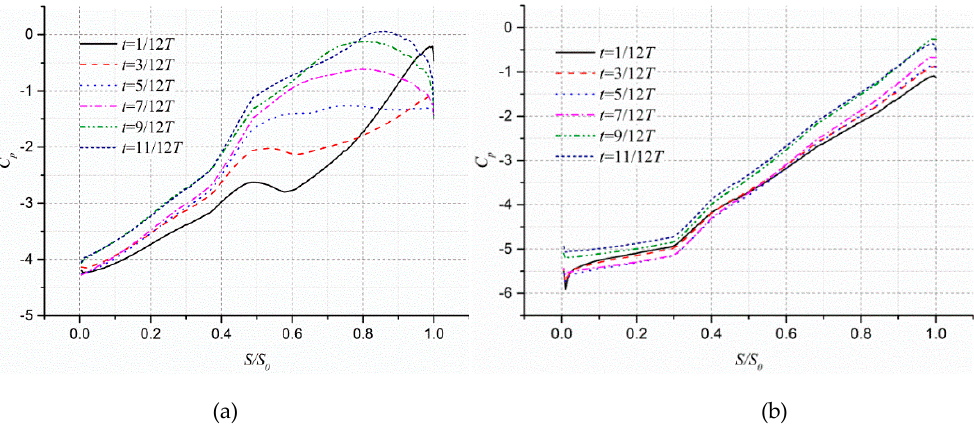
Figure 12. Distribution of the pressure coefficient on the blade surface for the Z / b 2 = 0.5 cross section: ( a ) pressure surface and ( b ) suction surface.